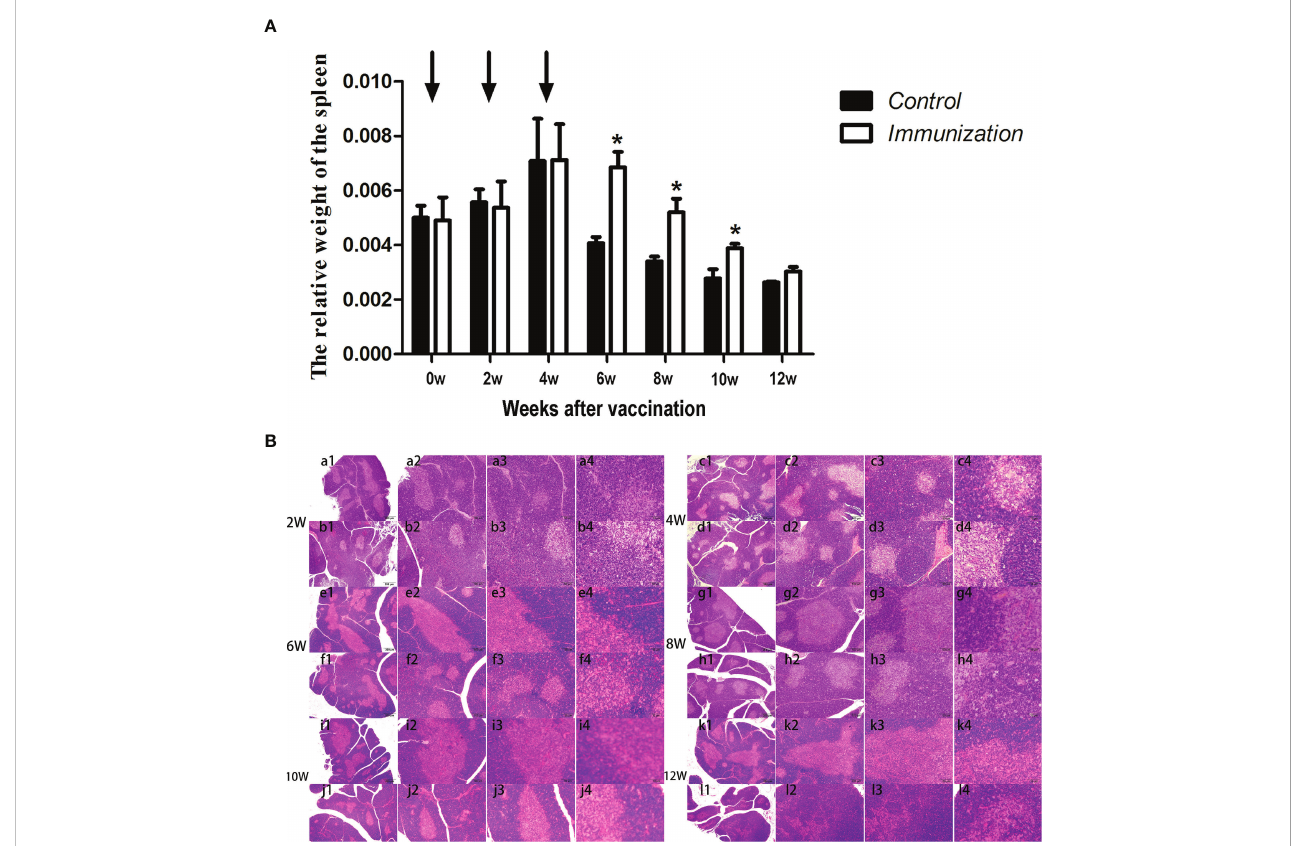
FIGURE 8 (A) Mean (± SEM) of the relative weight of the spleen in the gonadotropin-releasing hormone (GnRH) immunization group (n = 35) and the control group (n = 35). Arrows indicate primary vaccination and subsequent boosters. * Indicates a signi fi cant difference ( P < 0.05). (B) Histopathological observation of the spleen of the control group (a, c, e, g, i, k) and the gonadotropin-releasing hormone (GnRH) immunization group (b, d, f, h, j, l). All observations were performed on samples taken from 4-week-old rats after fi rst immunization. Numbers 1, 2, 3, and 4 represent a magni fi cation of 40, 100, 200, and 400 times,